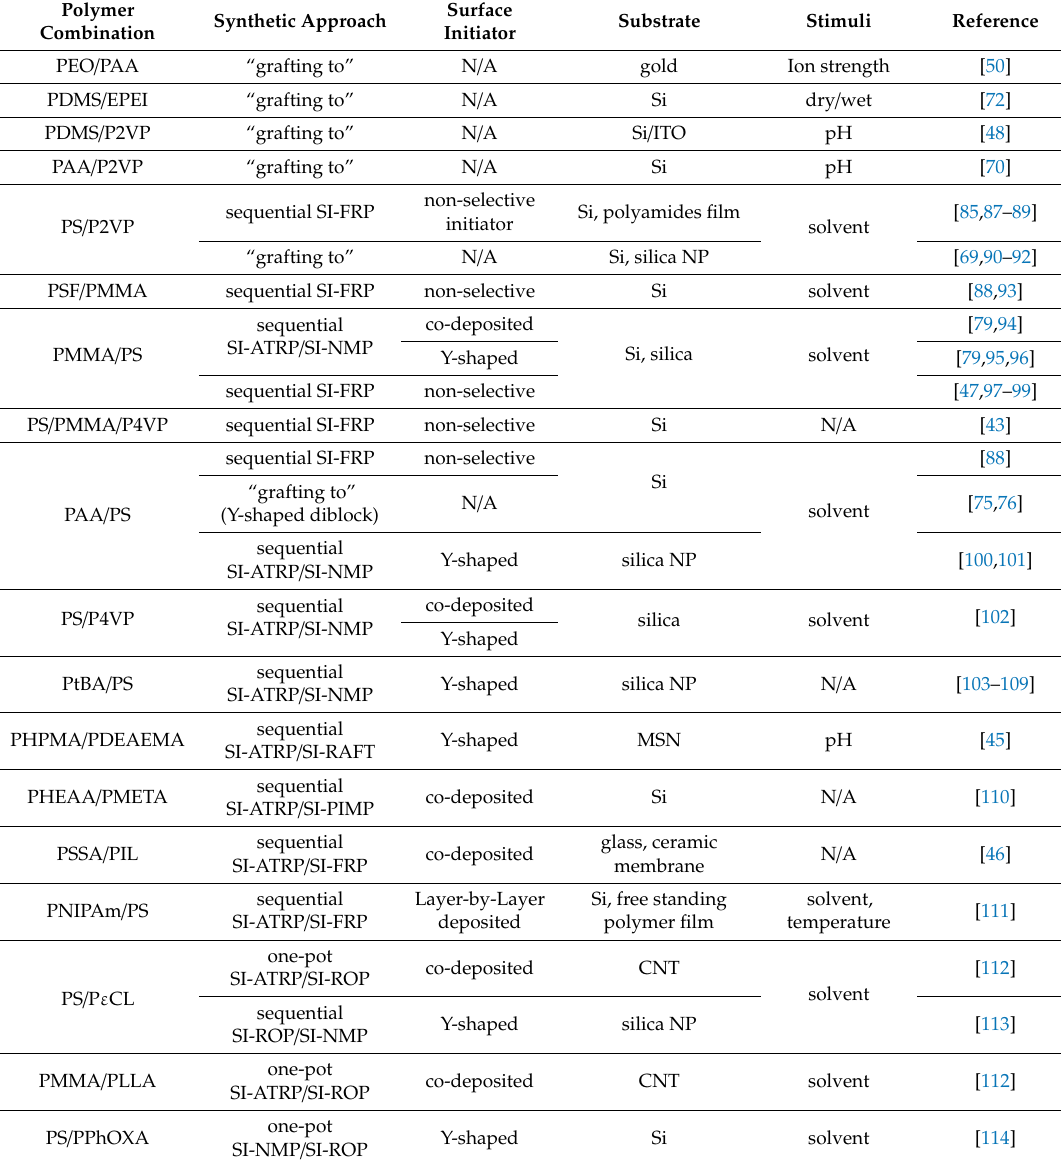
Table 1. An overview over mixed polymer brushes